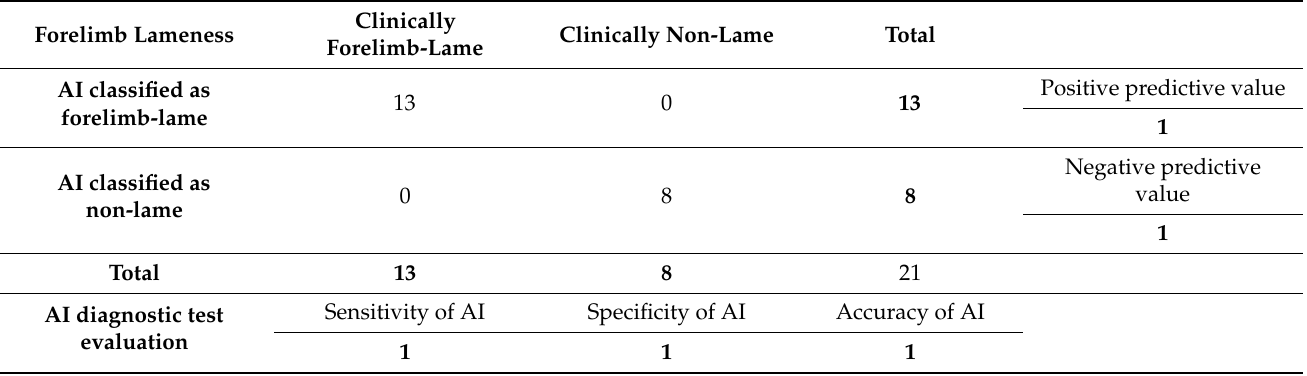
Table A4. Statistical classification of horses with and without forelimb lameness.